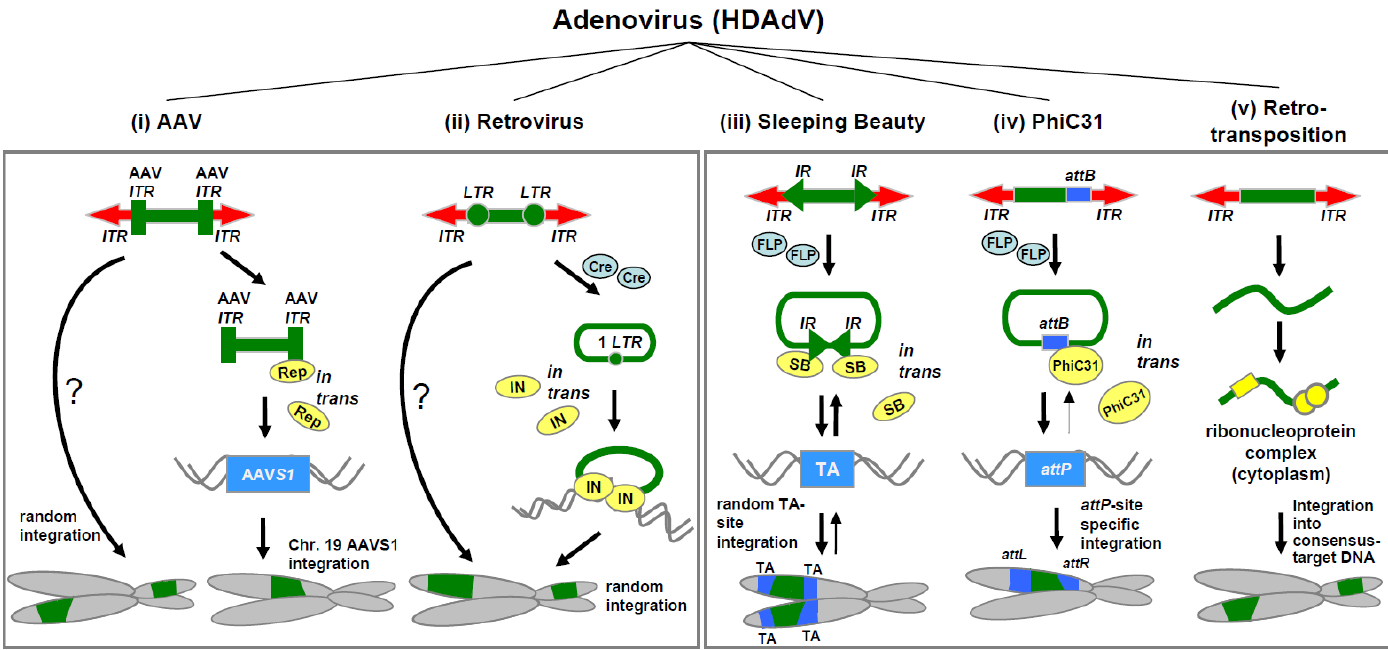
Figure 2. Schematic diagram of all integrating hybrid vector systems based on helper- dependent adenoviral vectors (HDAdV) as delivery vehicles (i-v). The transgene expression cassette (shown in green) and components for somatic integration are co-delivered using the recombinant adenoviral vector. Virus-based integration machineries are shown in the left panel and integration machineries based on non-viral systems are displayed in the right panel. (i) HDAdV/adeno-associated virus (AAV) hybrid vectors integrate into the host genome randomly via AAV internal terminal repeats (ITRs). Rep-Protein expressed in trans provided by a second vector mediates site-specific integration after binding to AAV-ITRs and to the AAV integration site S1 (AAVS1), located on the human chromosome 19. (ii) HDAdV/retrovirus (RV) hybrid vectors integrate transgene expression cassettes flanked by retroviral long terminal repeats (LTRs) directly or after circularization from the adenoviral vector genome mediated by Cre recombinase provided in trans . When the retroviral integrase (IN) is supplied in trans , the integration complex triggers the random insertion of the transgene into the host genome. (iii) For HDAdV/Sleeping Beauty (SB) transposase hybrid vectors the transgene is flanked by inverted repeats (IR) as a recognition site for the Sleeping Beauty (SB) transposase. SB is provided in trans together with Flp recombinase. When Flp mediates circularization of the DNA and therefore mobilization of the transposon from the HDAdV genome, SB binds to the recognition sites and integrates the transposon including the transgene randomly into the TA-sites of the host genome. This process is reversible. (iv) For the HDAdV/PhiC31 integrase hybrid vector system, the vector DNA harbours the PhiC31 recognition site attB within the therapeutic transgene. When PhiC31 protein is provided in trans , it mediates integration into a limited number of pseudo attP sites in the mammalian genome by unidirectional recombination. The circular form of the PhiC31 substrate is released from the adenoviral vector genome by Flp recombinase. At the time it is not clear whether this step is required. (v) Retrotransposition from the adenoviral vector genome is based on the interspersed element L1. After transduction of the target cell L1 and transgene is described and RNA leads to the generation of ribonucleoprotein structure in the cytoplasm. This complex is then imported into the nucleus for somatic integration into a consensus genomic target